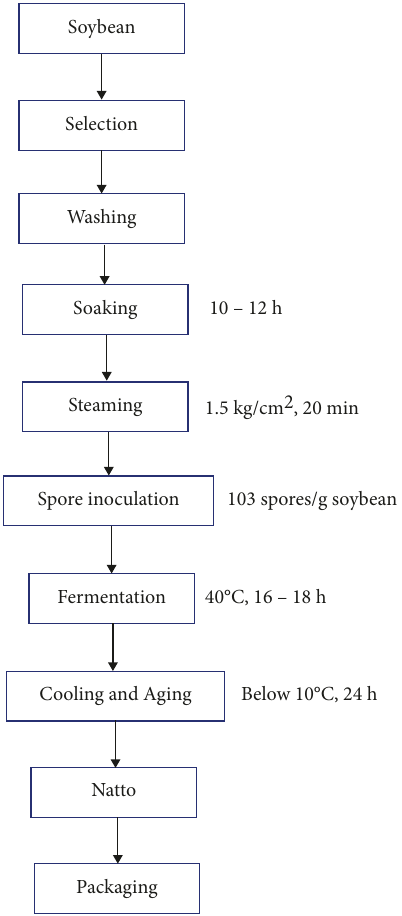
Figure 1: The mechanism of natto production is depicted in the flow sheet. Source: [14]. Table 1: Important microorganisms and enzymes used in food